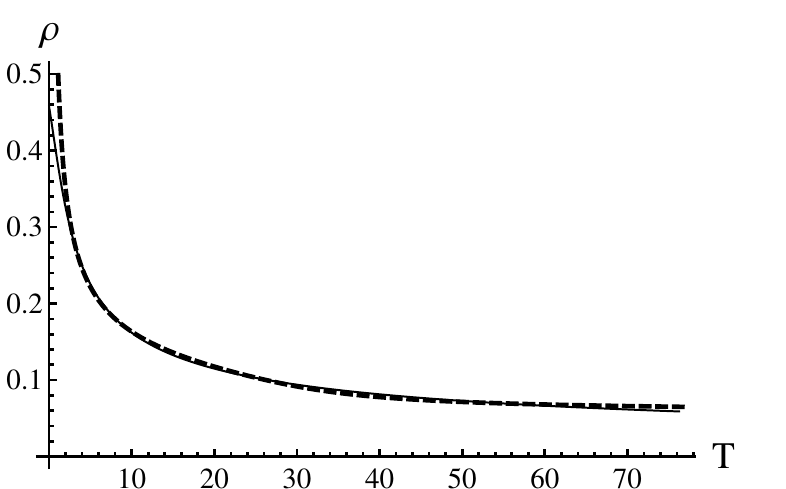
Figure 3 . Plot of resistivity versus temperature for z = 4 = 3 ; (cid:18) = 0 ; Q 2 = 10 and (cid:11) = 10. For these parameters the linear regime is no longer present. The dashed curved line represents the (cid:12)t (5.17) with coe(cid:14)cients A = 2 : 29 ; B = 2 : 67 ; C = 0 : 145 ; D = 1 :